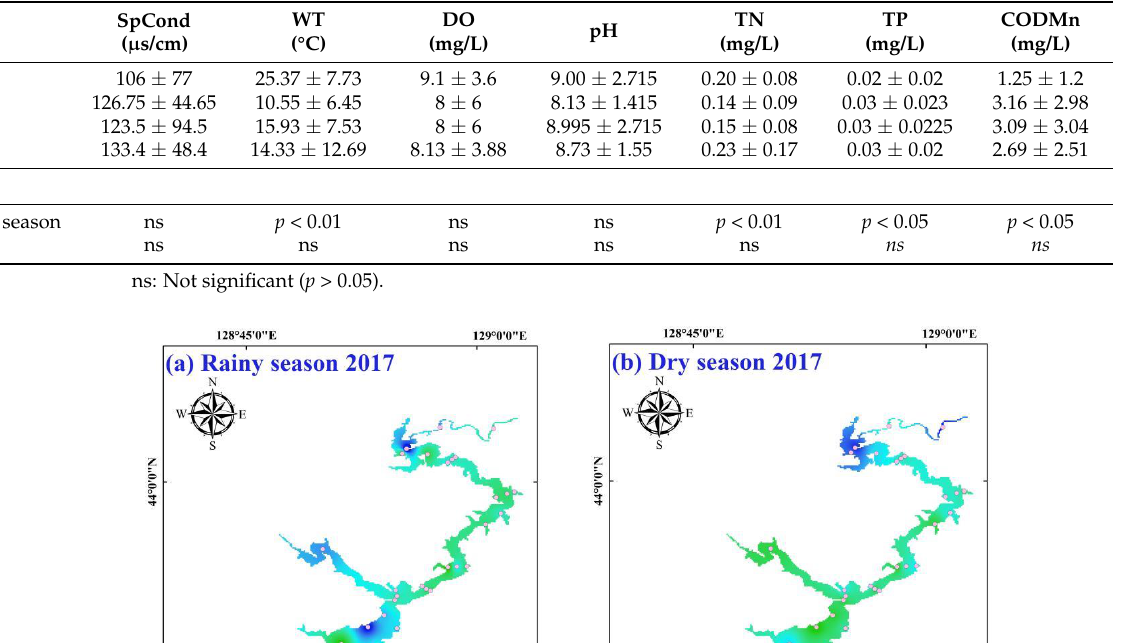
Table 1. The temporal and spatial variation of environmental parameters during the study period.